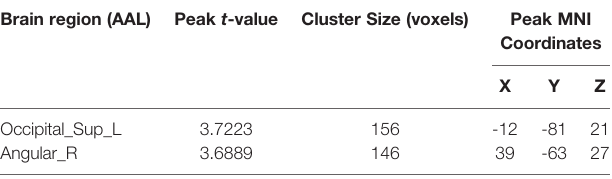
TABLE 2 | Regions with increased ALFF in HD group compared with CN group.